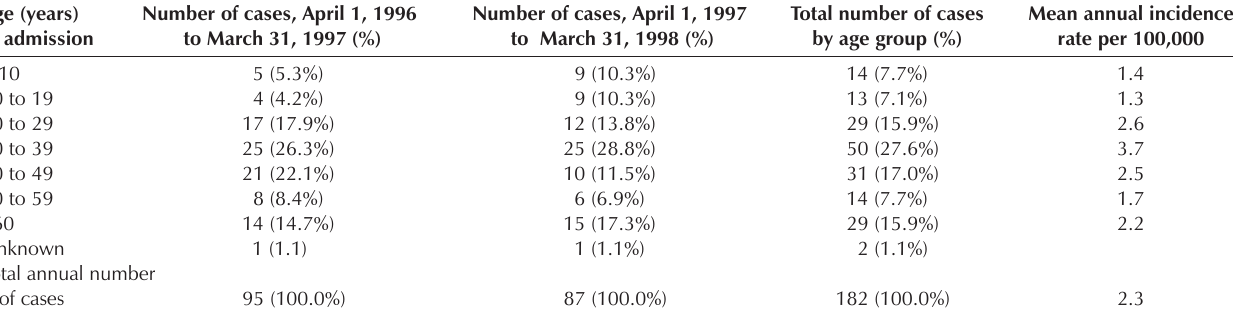
Age distribution of invasive group A streptococcus cases, British Columbia, April 1, 1996 to March 31,